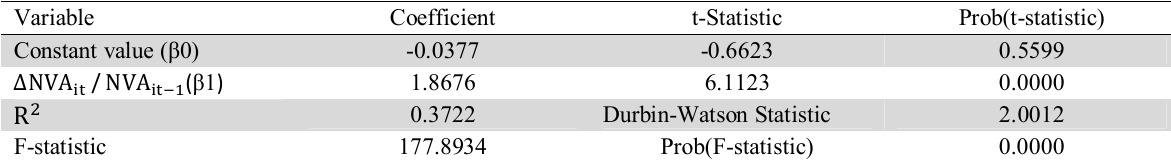
Results of the panel analysis to test the first hypothesis (H1) model Variable